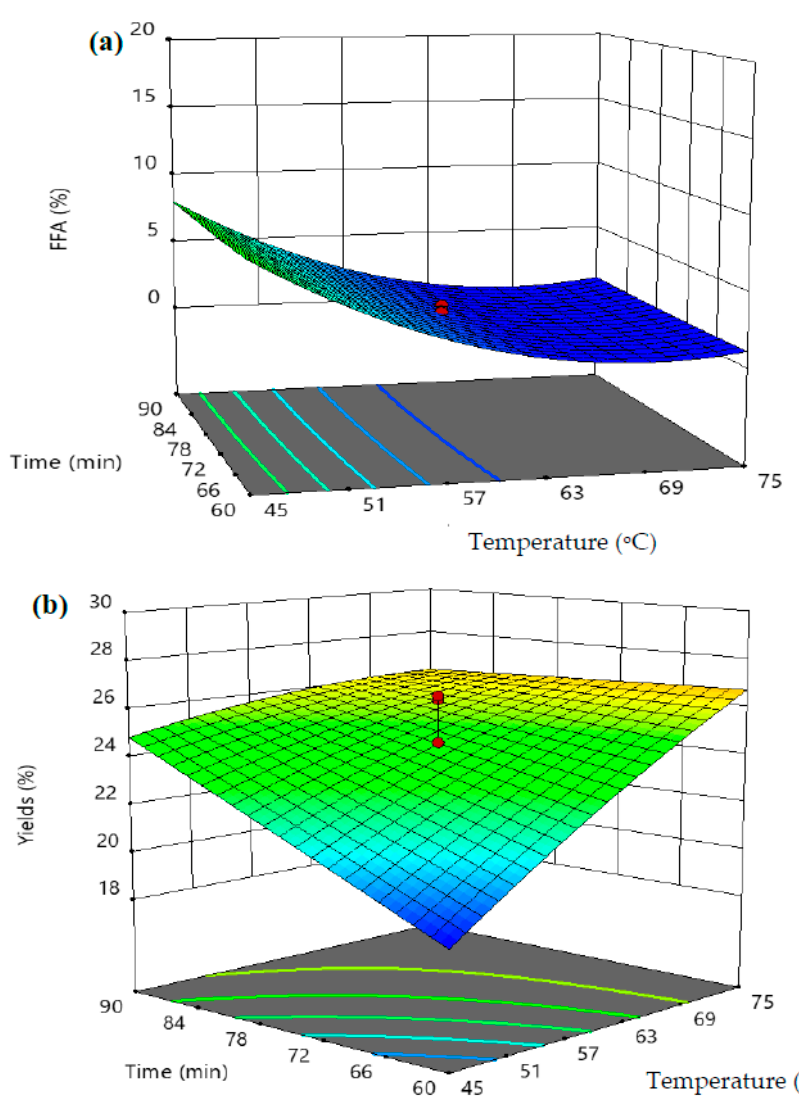
Figure 5. Interaction effects between the cold-pressed sterilization temperature and treatment time on FFAs in cold-pressed VPO ( a ) and VPO yield ( b ).